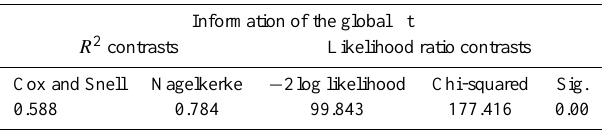
Table 6. Parameters of global fit of the model for HM. Chi-squared test for − 2LL reduction and several R 2 measures.